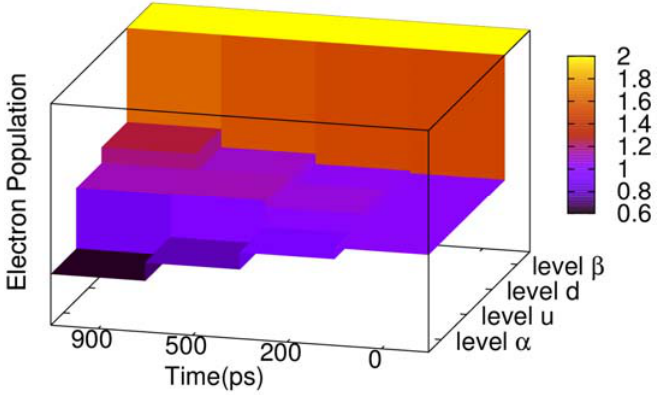
Figure 4. Three dimensional (3D) column chart of the evolution of the electron population of four energy levels of the negative polaron and triplet exciton for the time points of 0, 200, 500 and 900